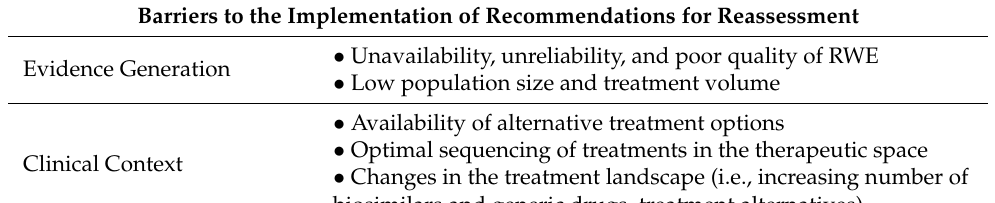
Table 4. Barriers and Facilitators to the Implementation of Recommendations for